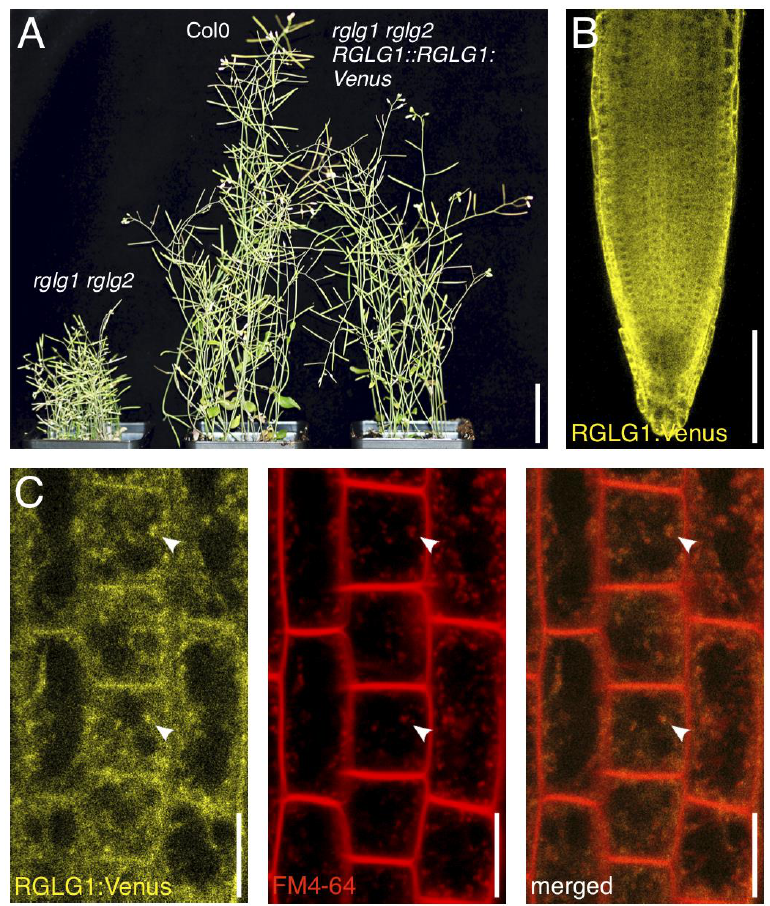
Figure 1. ( A ) Comparison of rglg1 rglg2 (left; 48 days after germination) Col0 wild type (middle; 32 days after germination) and rglg1 rglg2 RGLG1::RGLG1:Venus (right; 32 days after germination) plants. ( B ) Expression pattern of RGLG1::RGLG1::Venus (yellow) in rglg1 rglg2 roots at 6 days after germination. ( C ) Staining of RGLG1::RGLG1::Venus in rglg1 rglg2 root meristem epidermis cells (yellow, left panel) with FM4-64 (red, middle panel) for 10 min in the dark, followed by visualization at the Confocal Laser Scanning Microscope (CLSM). White arrowheads indicate co-staining (orange, right panel) in endocytosed compartments. Size bars: ( A ) = 3 cm; ( B ) = 50 μm; ( C ) = 10 μm .